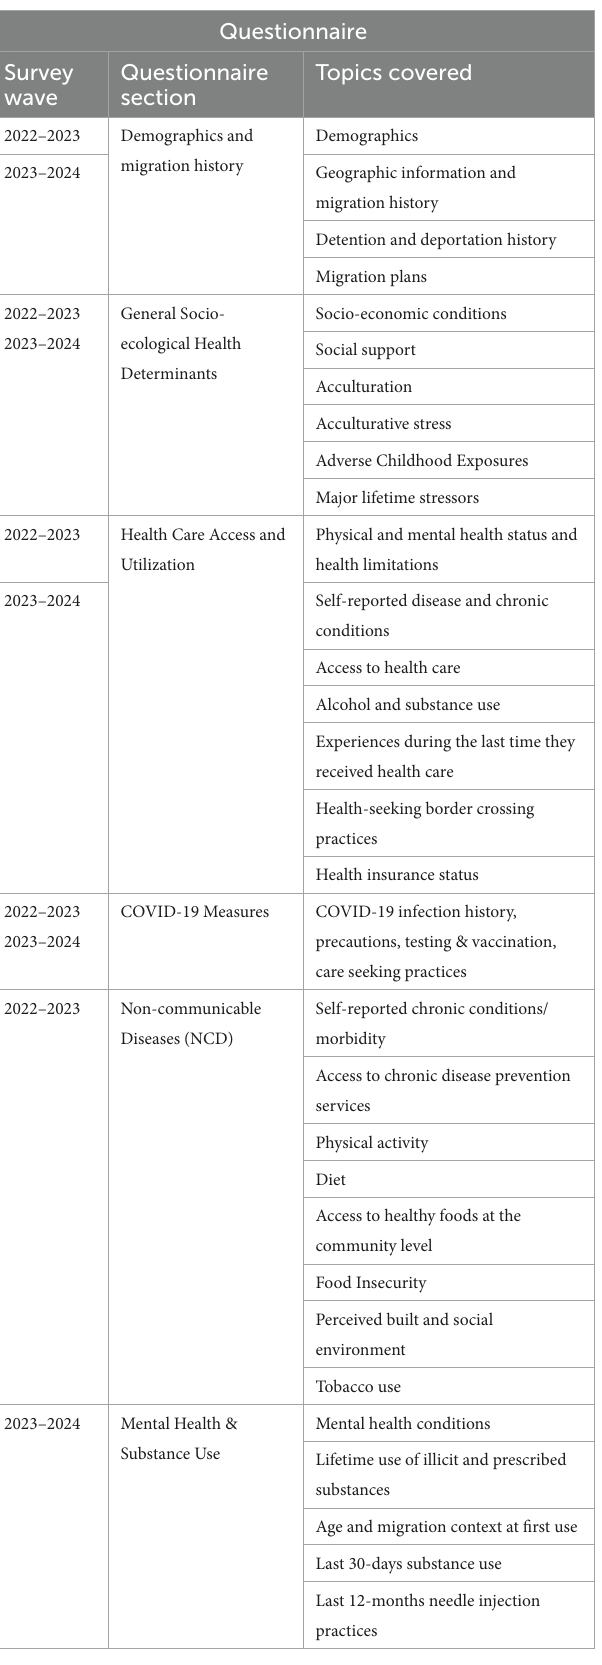
TABLE 1 Migrante Project survey measures and components (2022–